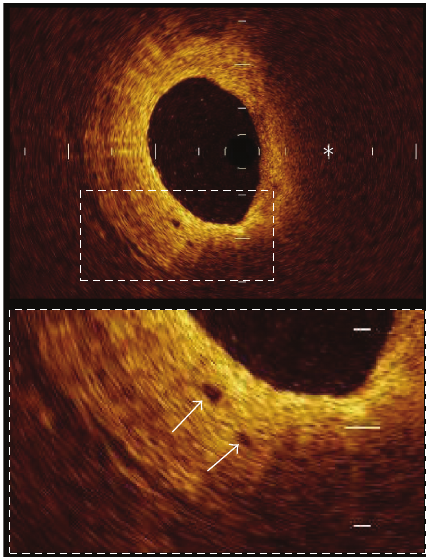
Figure 7: Plaque neovascularization. Microvessels within the intima (arrows) appear as signal poor voids that are sharply delineated. Two microvessels are located in thickened intima at 7 o’clock position. ( ∗ = lipid).